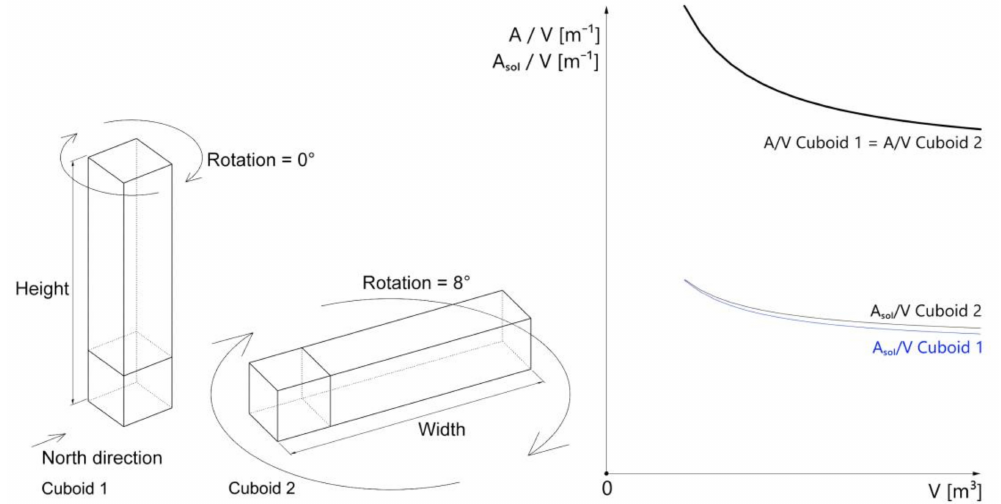
Figure 7. Cuboids designed with variations in height, width, or orientation to the north and their graphs of surface-area-to-volume ratio and solar-surface-area-to-volume